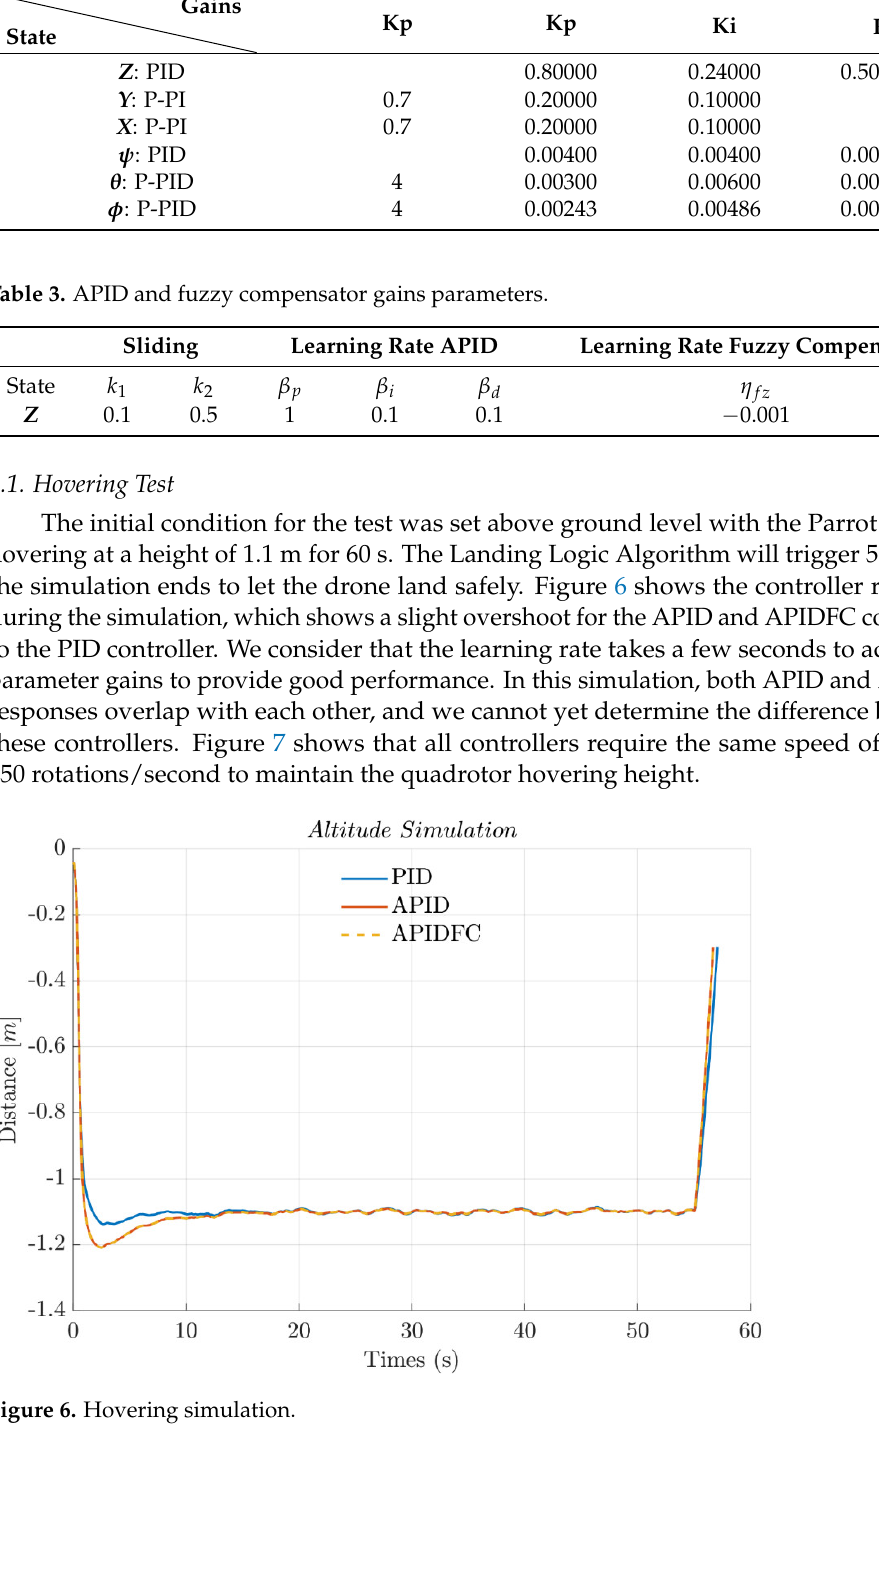
Figure 7. Motor rotation speed in the hovering simulation. 4.2. Altitude Tracking Test Three simulations were conducted in this tracking; sine wave, square wave, and tra- pezium wave tracking. Sine wave tracking is conducted to observe the smoothness of the quadrotor in following the curve signals, while square wave and trapezium wave tracking are performed to check the response of the quadrotor when the altitude changes to a certain level. From the simulations, all controllers can adequately track the desired responses with minimum error. However, the PID controller produces a slight overshoot compared to the APID and APIDFC. Both APID and APIDFC still overlap with each other, and we cannot yet determine which one is better. All the tracking responses are shown in Figures 8–10.